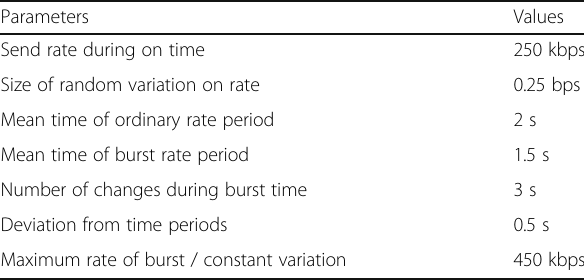
Table 3 Variable bit rate simulation parameters